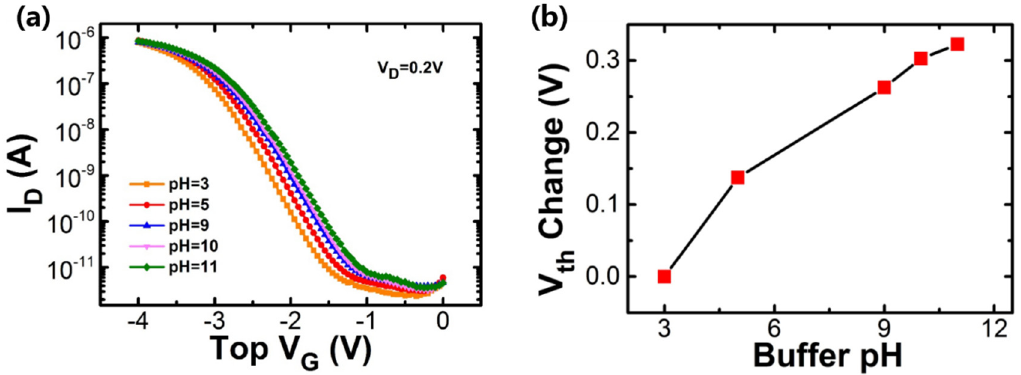
Figure 9. ( a ) The transfer curves of the silicon-on-insulator (SOI) sensor with different pH solutions, ( b ) threshold voltage under different pH solutions. ( b ) threshold voltage under di ff erent pH solutions.